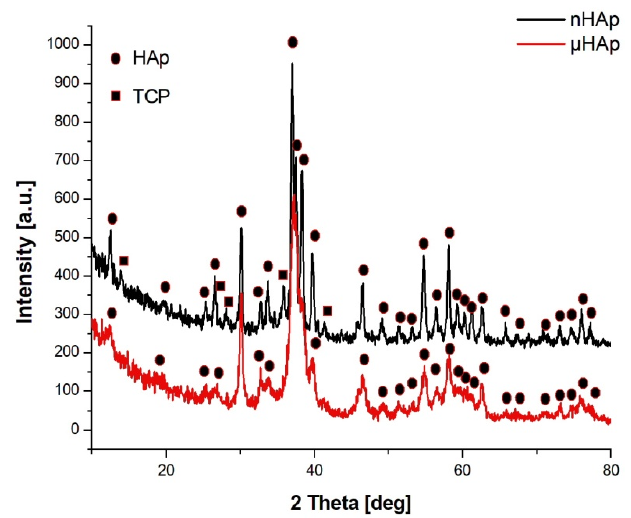
Figure 2. X-ray diffractograms of the nHAp and µHAp powders tested.